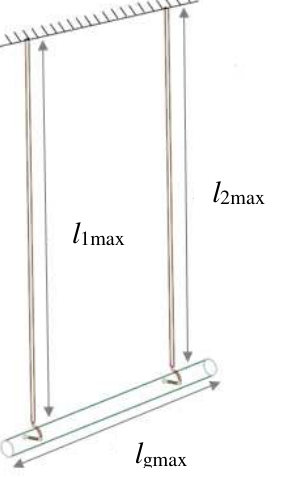
Fig. 2. Model of the whole light